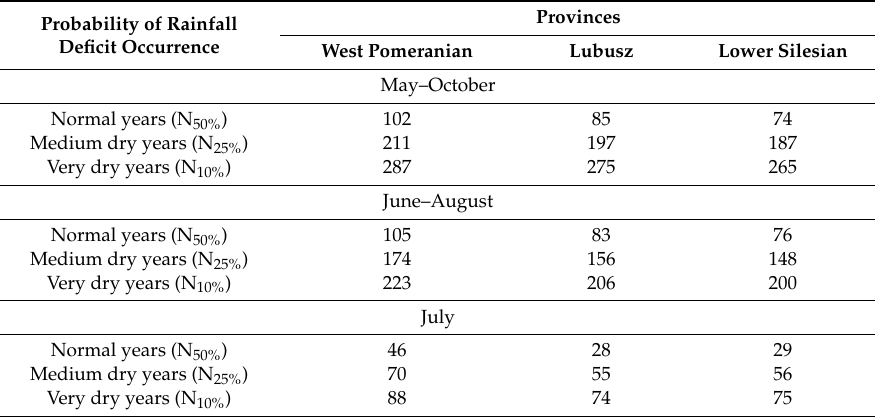
Table 6. Rainfall deficit (N) of grapevines (mm) in the provinces of western Poland. Probability of Rainfall Deficit Occurrence